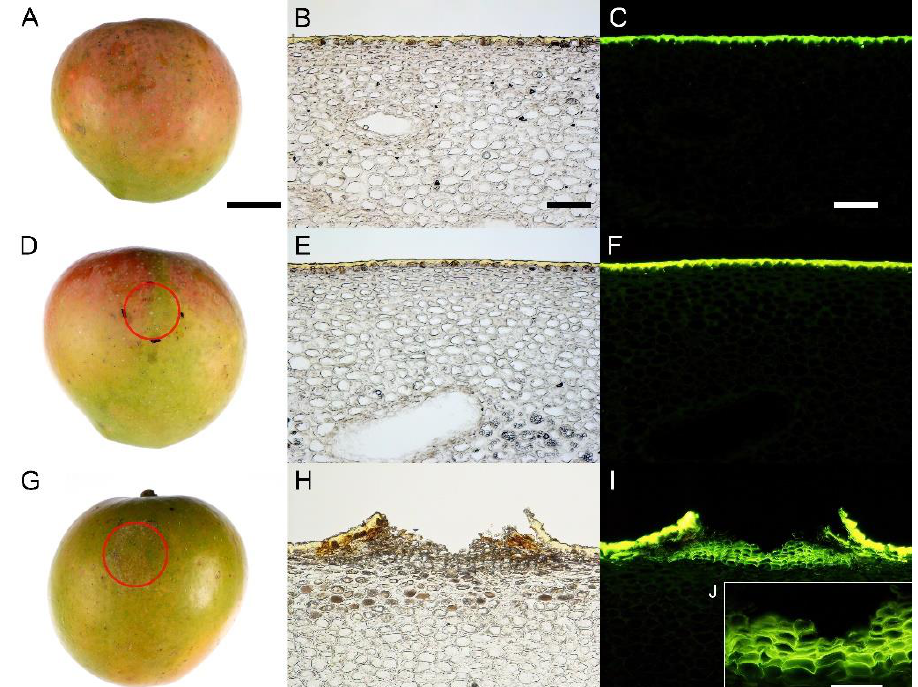
Figure 5. Images of mature fruits of mango cv. apple ( A , D , G ) and histological micrographs of moisture-treated and control fruit skin taken under bright ( B , E , H ) and incident fluorescent light ( C , F , I ) as affected by a surface moisture treatment (see text for details). Control fruit (no tube attached, not exposed to moisture) ( A , B , C ), open tube (tube attached but not exposed to moisture) ( D , E , F ) and moisture-treated fruits (tube attached and exposed to moisture) ( G , H , I ) and enlarged micrograph of moisture-treated skin ( J ). Fruit was exposed to surface moisture by attaching a tube filled with distilled water to the fruit surface for 16 days at 53 days after full bloom (DAFB). Untreated fruit and fruit with an open tube attached that remained dry served as controls. At the end of the treatment period, tubes were removed and fruits were left to grow to maturity. The red circle identifies the area previously enclosed by the plastic tube. N = 18–20 (whole fruits) and 3 (histology). The scale bars are 20 mm ( A , D , G ), 100 µm ( B , C , E , F , H , I ) and 50 µm ( J ).